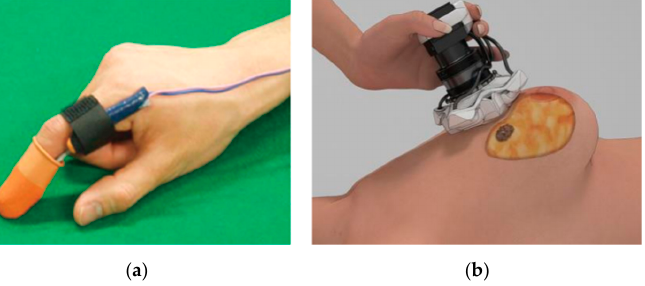
Figure 1. ( a ) Prostate-cancer diagnosis based on tactile sensation "Reproduced with permission from [Ahn, B.; Park, K.; Lee, H.; Kim, J..], [A Survey of Robotic Technologies for Diagnosis and Treatment of Prostate Cancer.]; published by [Control, Robotics and Systems], [ 2010 ]. ” [8]. ( b ) Breast-cancer diagnosis based on optical tactile elasticity "Reproduced with permission from [Yang, S.; Lee,